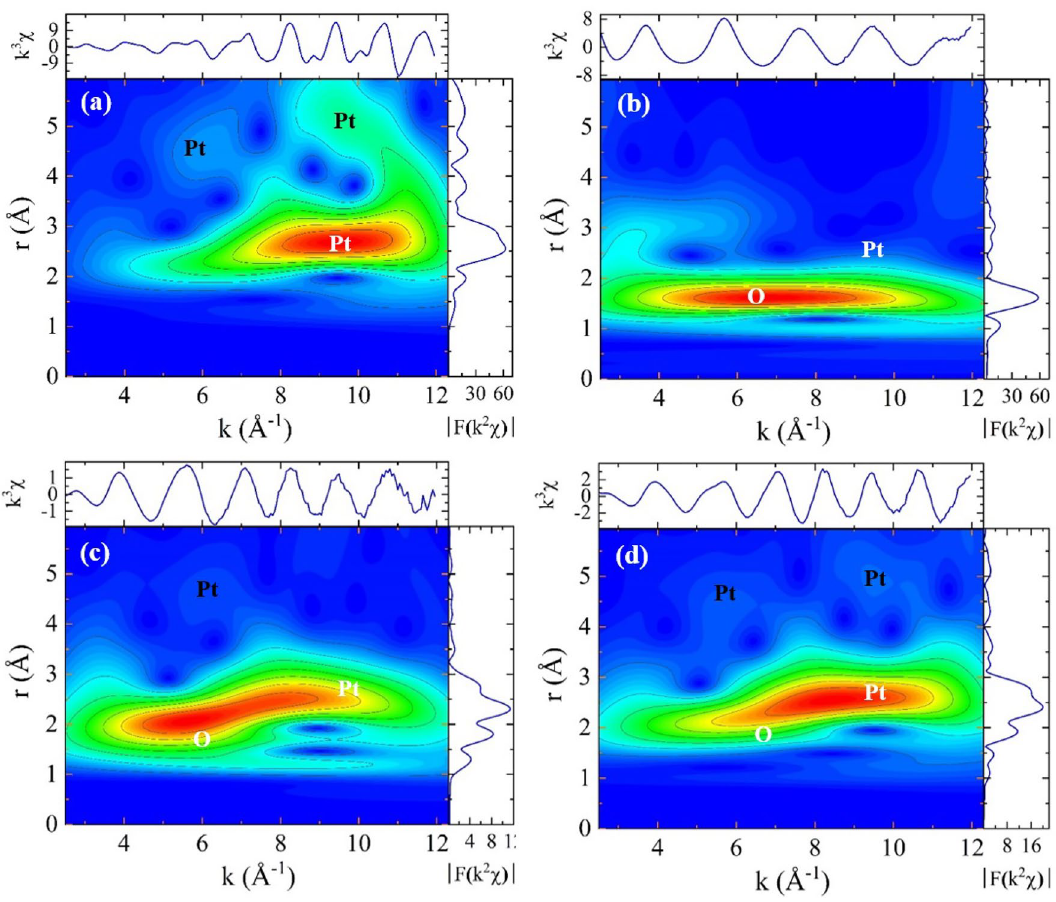
Figure 7. At Pt L 3 edge, WT-EXAFS of ( a ) Pt foil at RT, ( b ) RT, ( c ) 200 °C, and (d) RT c of H 2 O 2 -Pt/Ti–FS. The top and the right data are the measured EXAFS in the k-space and FT-EXAFS in the r-space,